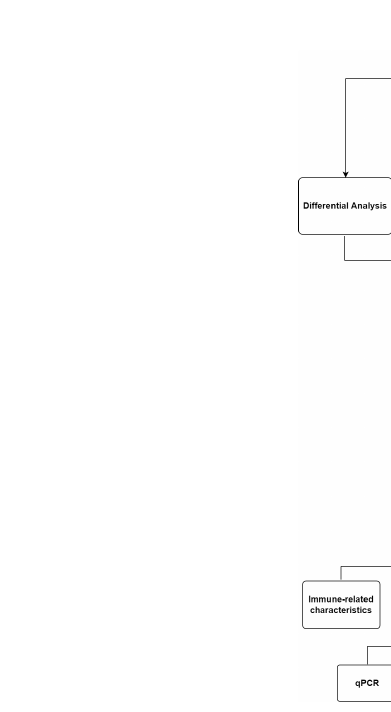
FIGURE 1 Flow Diagram of